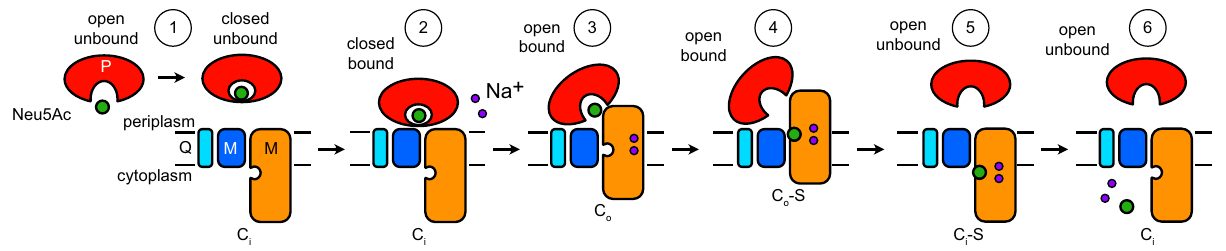
Fig. 7 Proposed mechanism of TRAP transporters. The schematic shows the components of the transport reaction in the different steps (numbers in circles) of the proposed transport mechanism, which are explained in the main text. The conformational state of the QM domains is annotated: C i — inward open; C o — outward open; C o -S — outward open, substrate bound; C i — S inward open, substrate bound. Neu5Ac — sialic acid ( N -acetylneuraminic